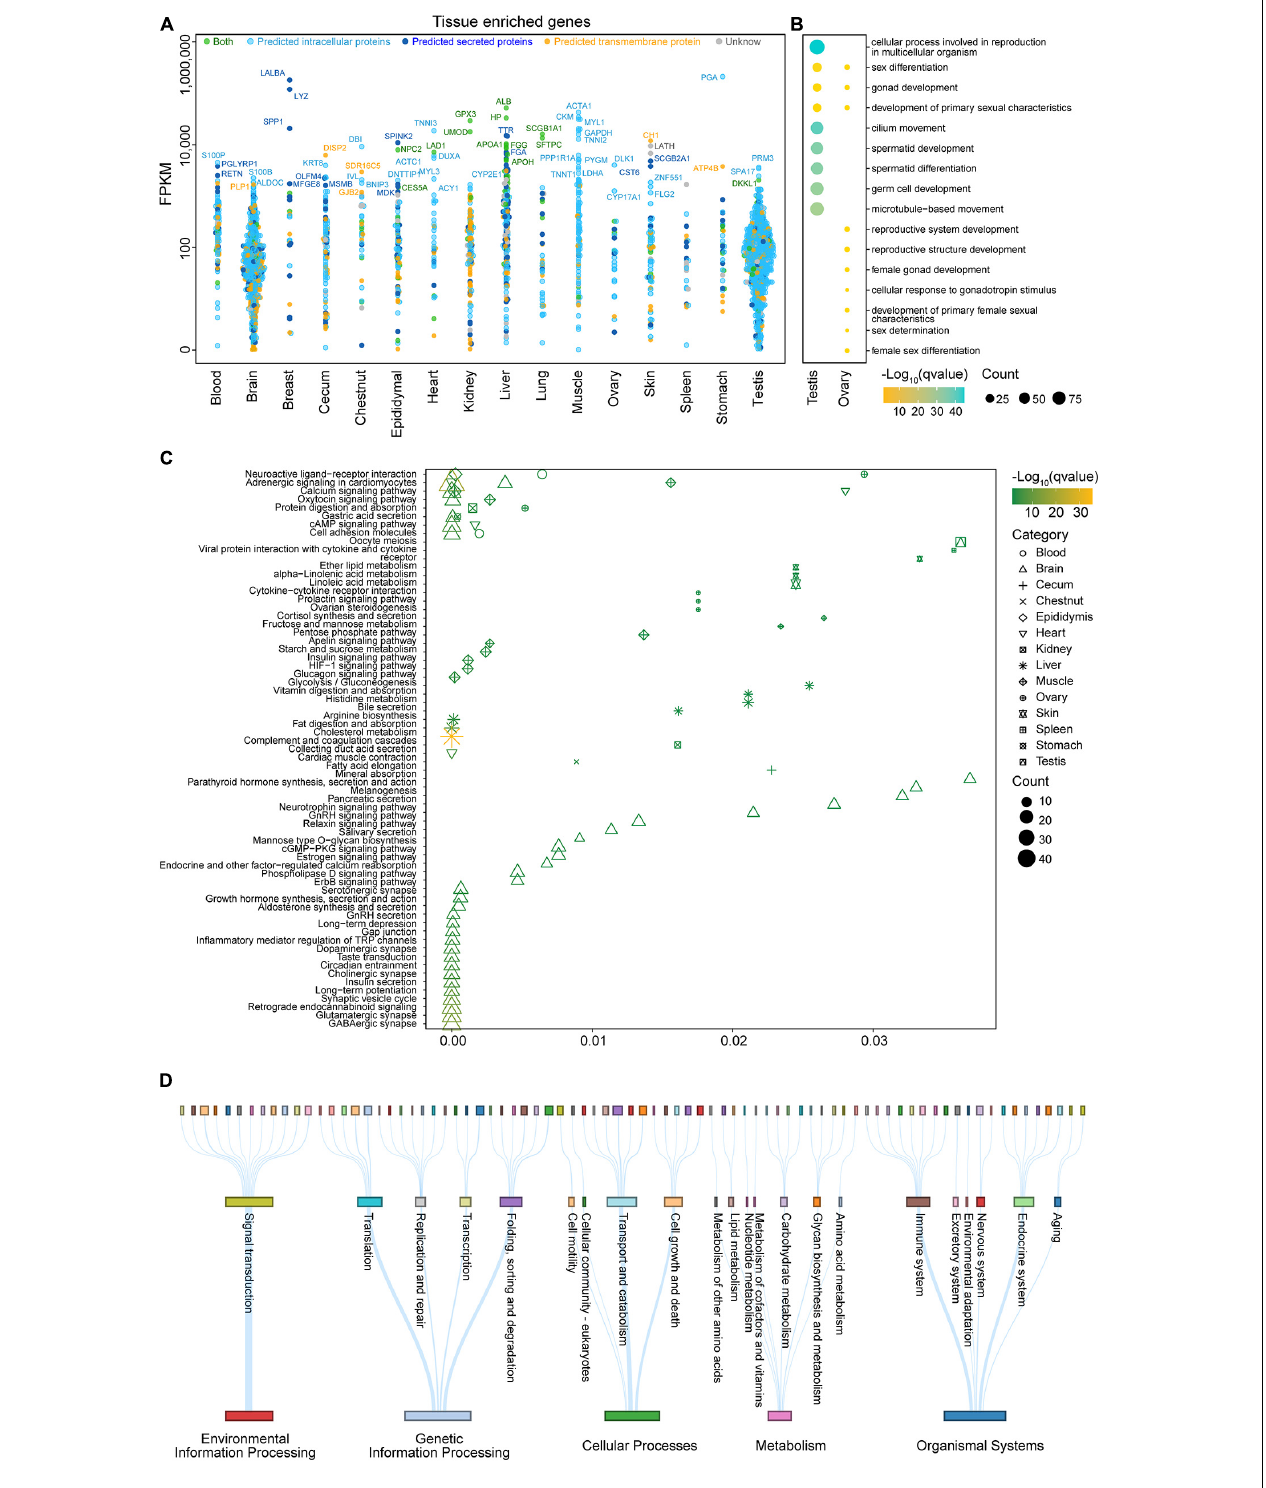
FIGURE 3 | Analysis of tissue-enriched genes in different organ systems and ubiquitously expressed genes. (A) The transcript levels (fragments per kilobase million, FPKM) on a log10 scale for all genes identified as tissue-enriched are shown for 16 tissues, with each gene stratified according to the predicted localization. (B) An analysis of significant Gene Ontology (GO) terms (biological process) for the testis and ovary based on the tissue-enriched genes which were categorized on the basis of FPKM (for more details on the GO analysis, see Supplementary Table 4 ). (C) A Kyoto Encyclopedia of Genes and Genomes (KEGG) pathway analysis for all tissues based on the tissue-enriched genes which were categorized on the basis of FPKM (see Supplementary Table 5 for more details). (D) A KEGG pathway analysis for ubiquitously expressed genes which were categorized on the basis of FPKM. Each row represents a different KEGG level. The thickness of the lines and the sizes of the squares are proportional to the number of genes in the corresponding pathway (see Supplementary Table 6 for more details). Frontiers in Genetics |